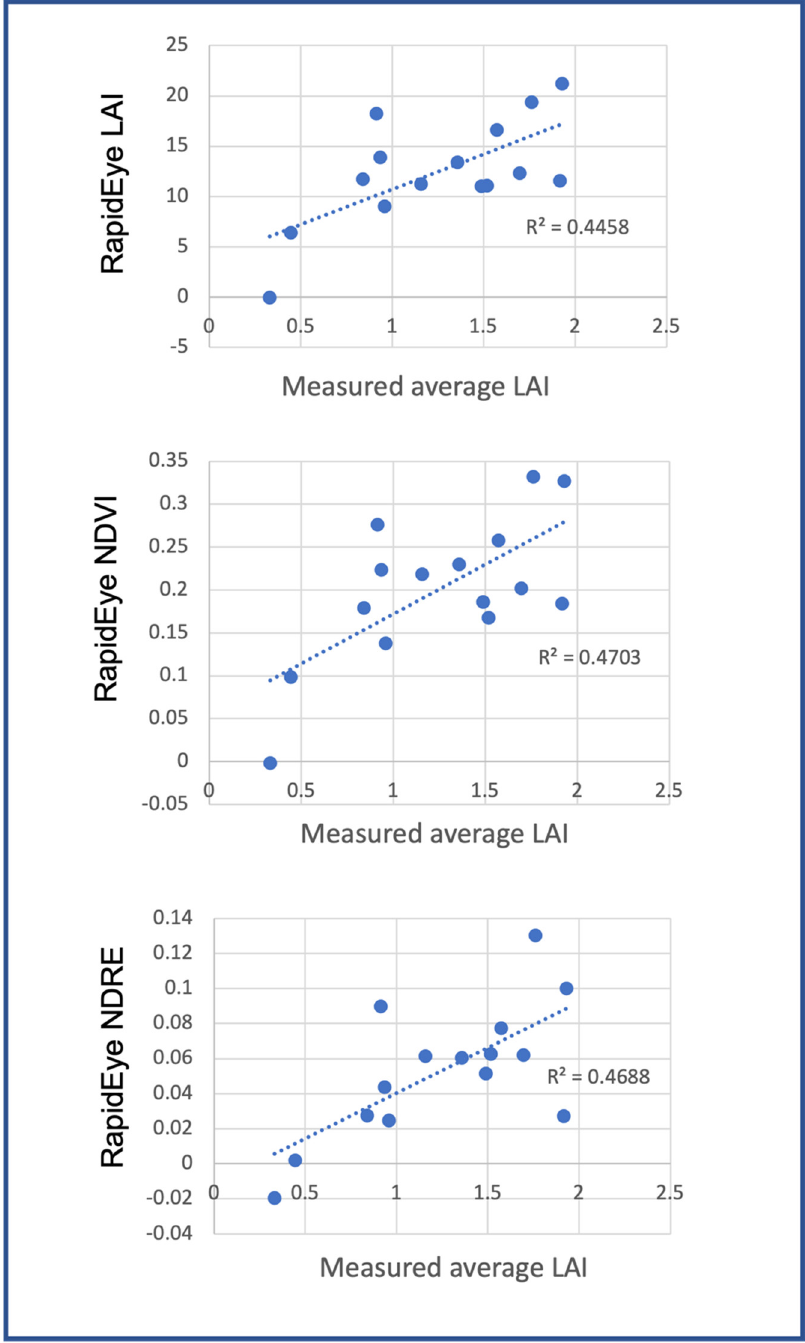
Figure A2. Comparing clustered field measured LAI with RapidEye LAI, NDVI, NDRE for Minerva Hills National Park.